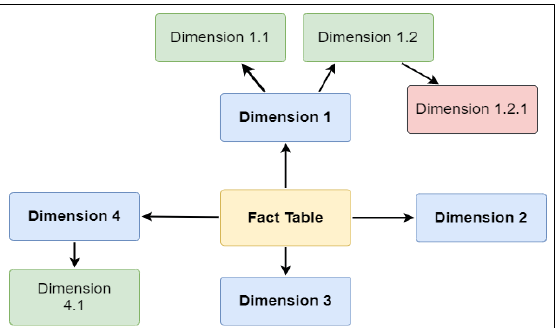
Figure 4 . A Snowflake schema